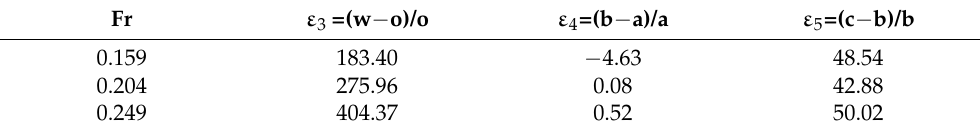
Table 7. Error analysis in model scale (unit: